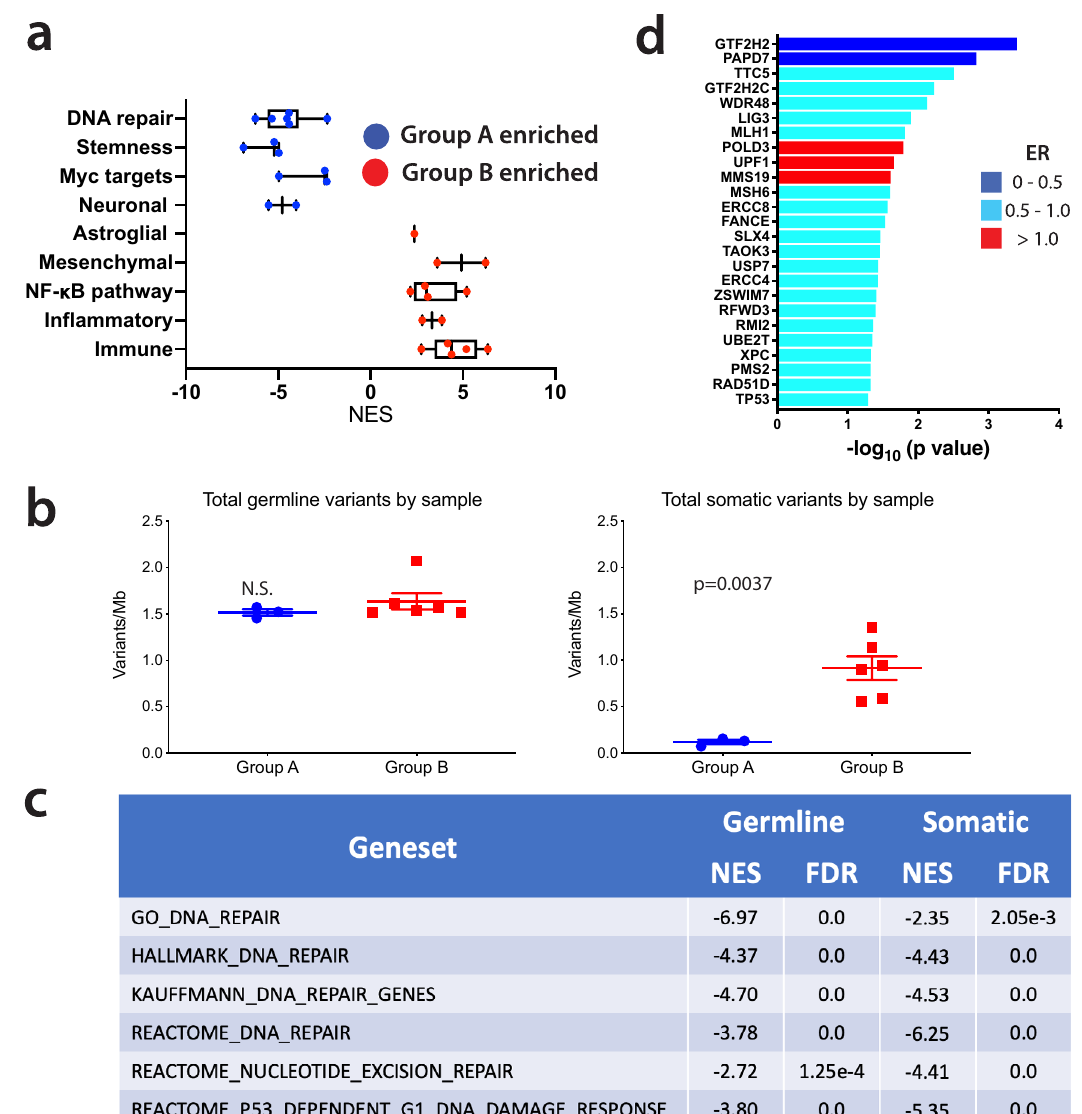
Fig. 6 Gene expression and genetic pro fi ling of Group A versus Group B RIG. a GSEA results showing GO NES differences by category between Group A (blue) and Group B (red) RIG tumors; horizontal axis is NES for comparing RIG Group B vs. RIG Group A (NES > 0 means enrichment in Group B and NES < 0 means enrichment in Group A; FDR values for comparisons are listed in Supplementary Data 15); Box-plot midline shows median; hinges are at 25th and 75th percentiles; whiskers show minimum and maximum NES values for each geneset. b For RIG samples with germline and somatic genome sequencing and transcriptomic data, germline variant load was identical between subgroups, but the somatic load was approximately ninefold greater in Group B ( P = 0.0037); the RIG sam p le with MSH2 mismatch repair defect was excluded from this analysis. c GSEA results for DNA-repair pathways for Group B versus Group A germline and tumor samples; negative numbers represent depletion in Group B versus Group A. d Differences in expression for pre-selected individual genes from the DNA-repair genesets that were judged to be most re fl ective of DNA-repair ef fi ciency are shown by decreasing P value (top to bottom); colors represent the log 10 ratio of fold change in Group B versus Group A. NES normalized enrichment score, RIG